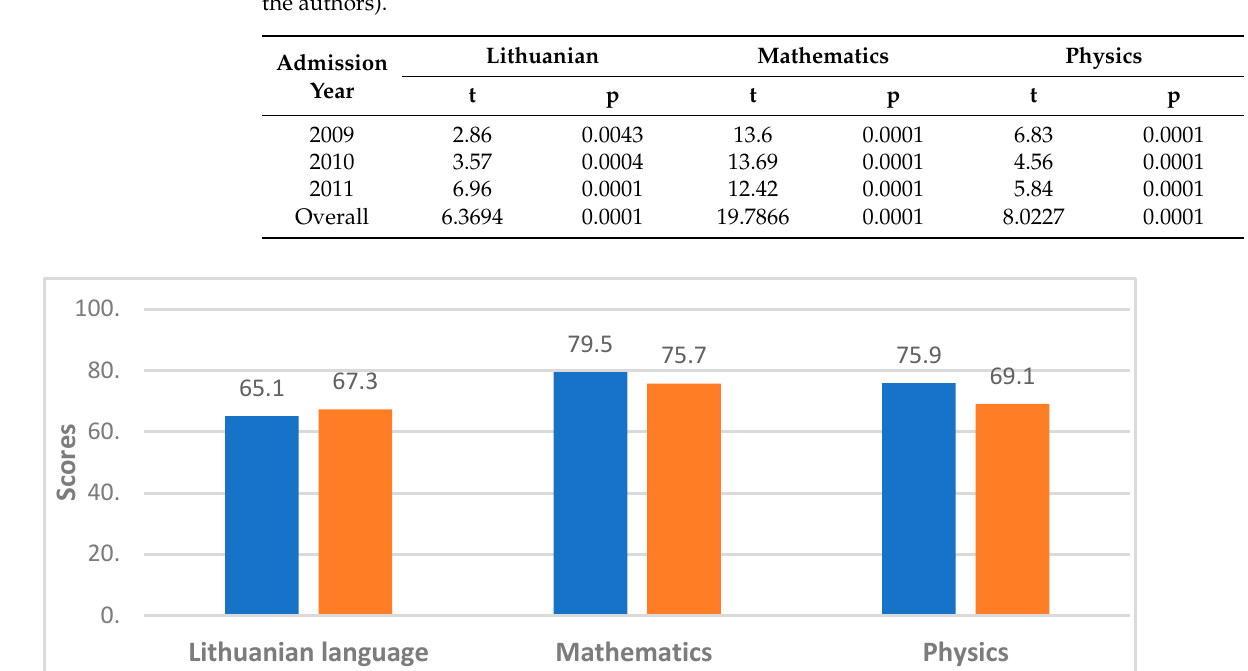
Table 2. Comparison of the maturity examination results of the students enrolled in the aircraft piloting study program with the mean scores of the school graduates of Lithuania (source: created by the authors).